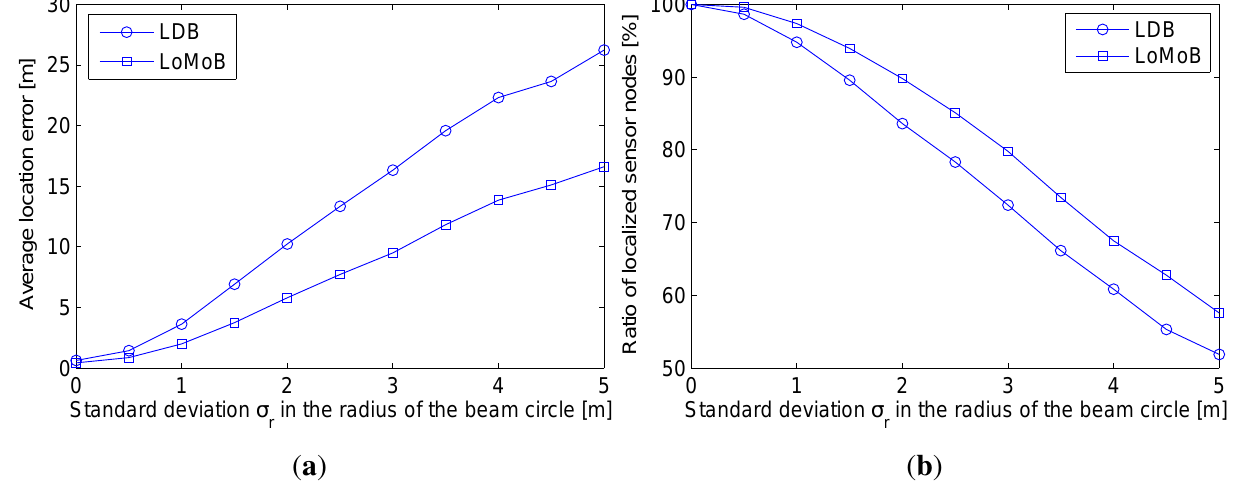
Figure 8. Localization accuracy as a function of standard deviation (cid:27) circle formed by the transceiver’s beam. ( a ) Average location error; ( b ) Ratio of localized sensor